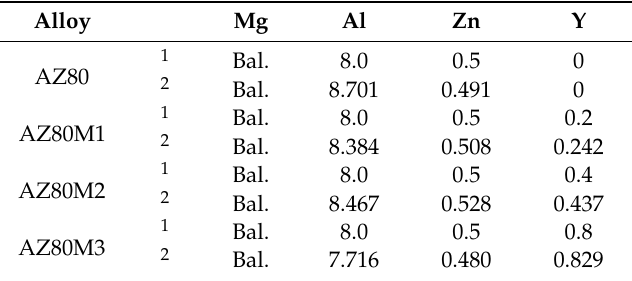
Table 1. Chemical composition of experimental alloys (wt. %). Alloy Mg